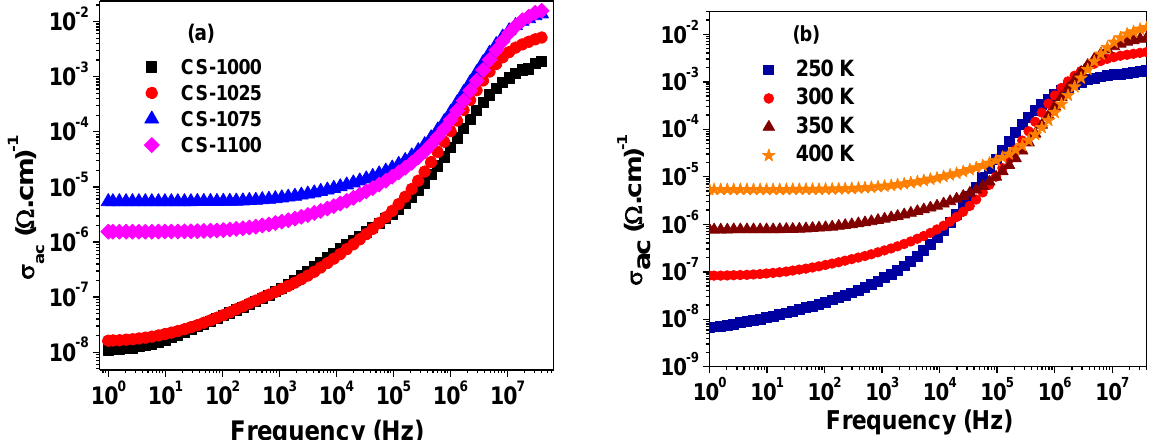
Figure 8. ( a ) Frequency dependency of σ ac at 400 K for NSCTO samples and ( b ) frequency dependency of σ ac at selected temperatures for CS-1075 NSCTO sample.